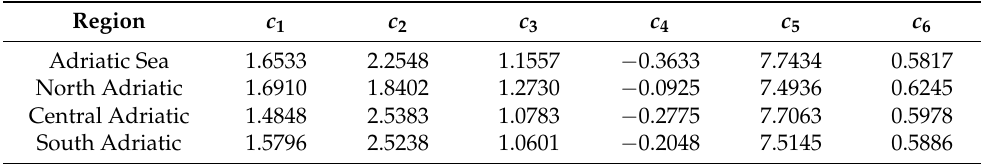
Table 4. Model parameters for joint distribution of Hs and u_w . Adriatic regional subdivision. Region